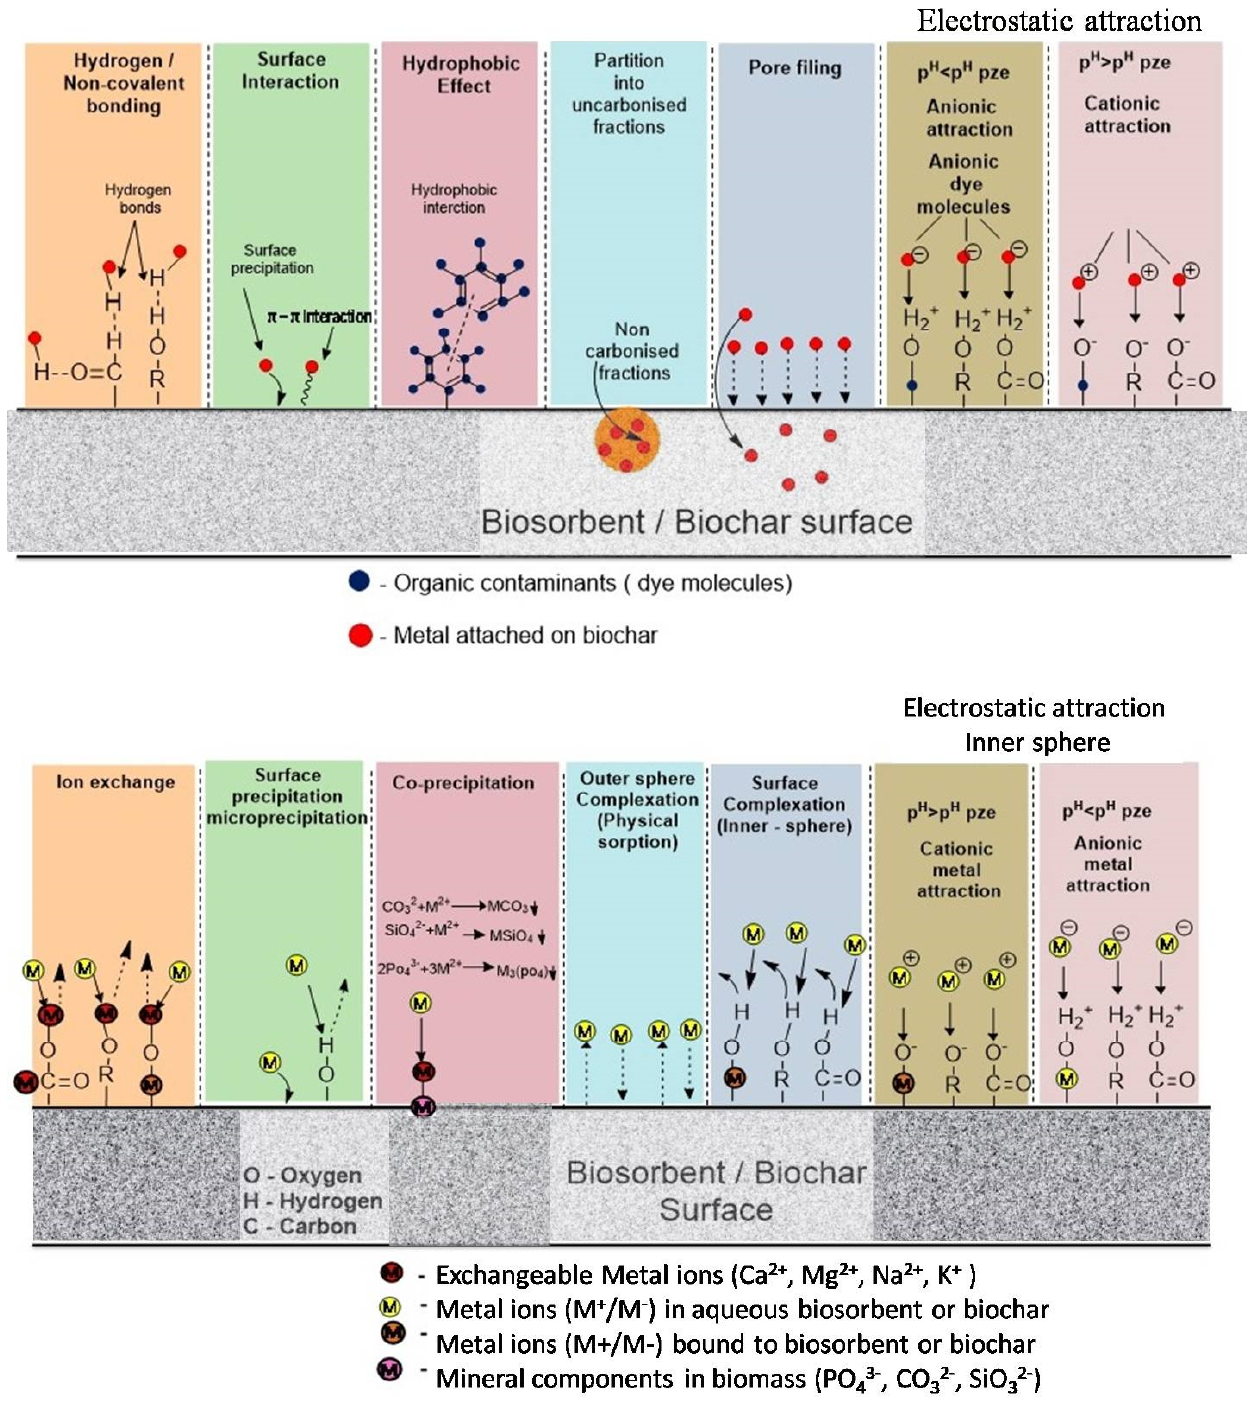
Figure 9. Mechanism of adsorption of dyes and heavy metals from industrial wastewaters by citrus biomass-derived bio-sorbent. Artwork developed from the information provided in [47].